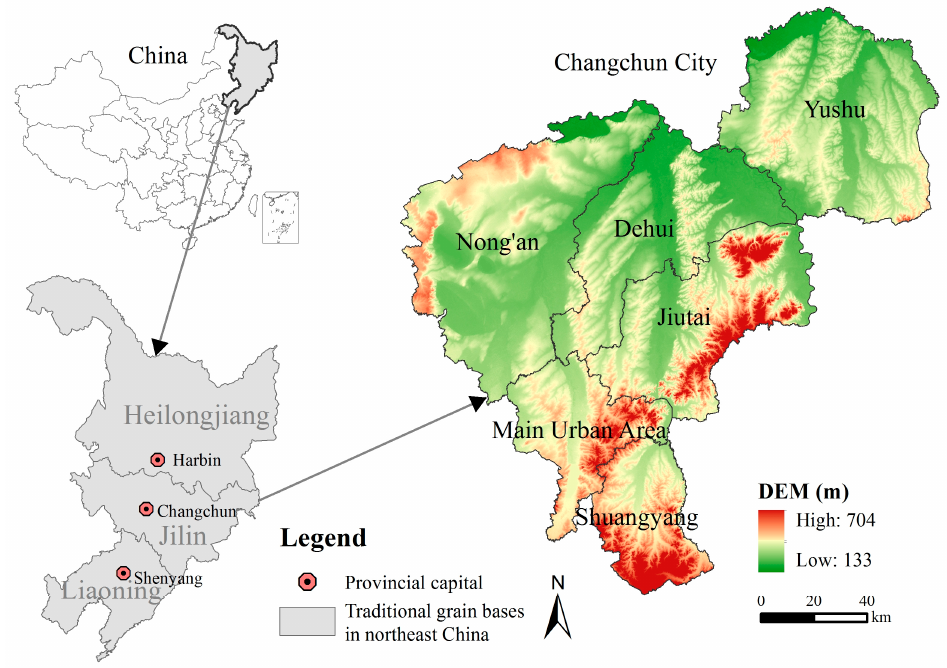
Figure 1. Overview map of the study area.